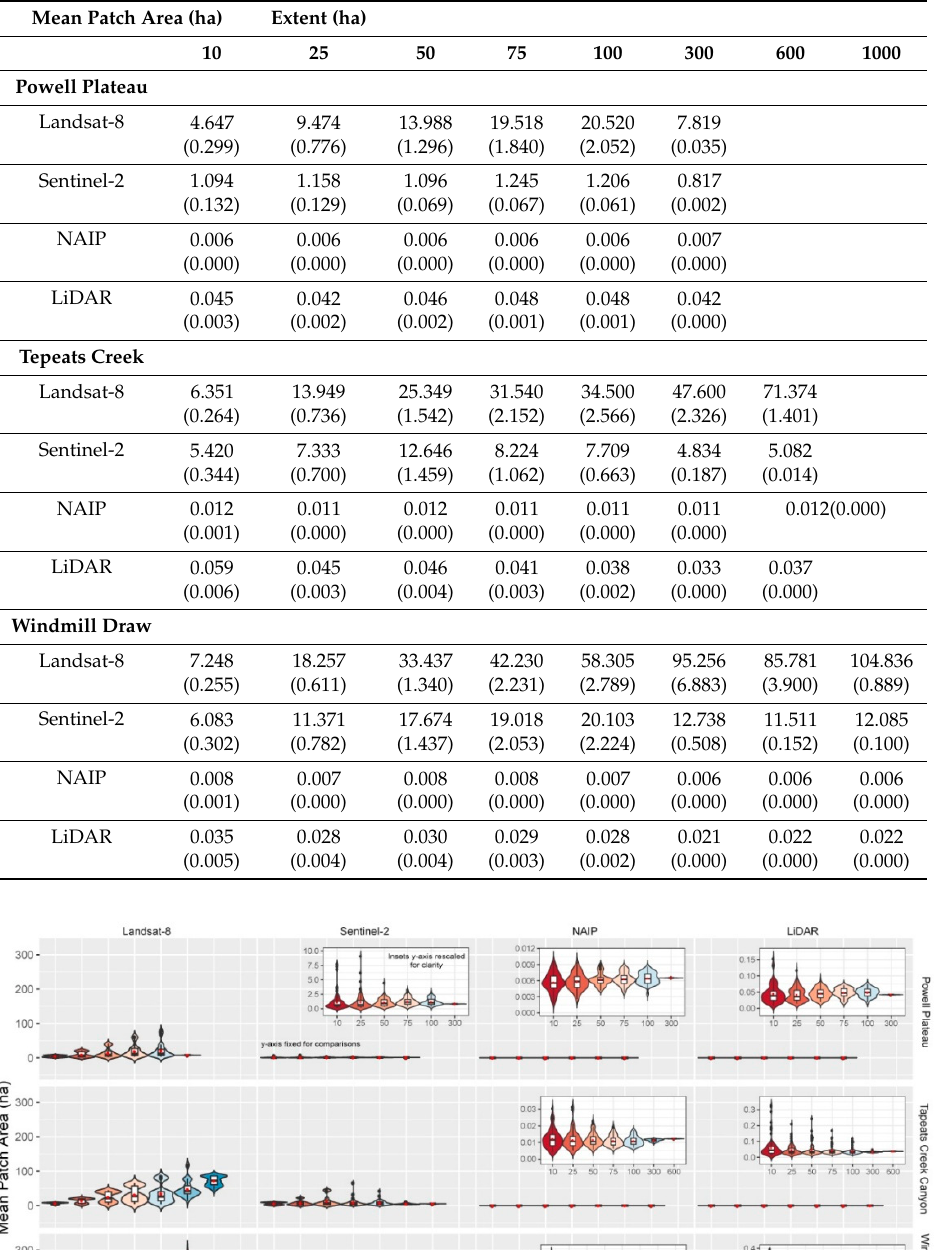
Table 4. Mean Patch Area (MPA) (ha), the average area composed of patches of canopy cover, across each landscape and data product (Landsat-8 30 m, Sentinel-2 10 m, NAIP 1 m, LiDAR 1 m), and across multiple spatial extents. Mean values and standard error (SE) are shown.